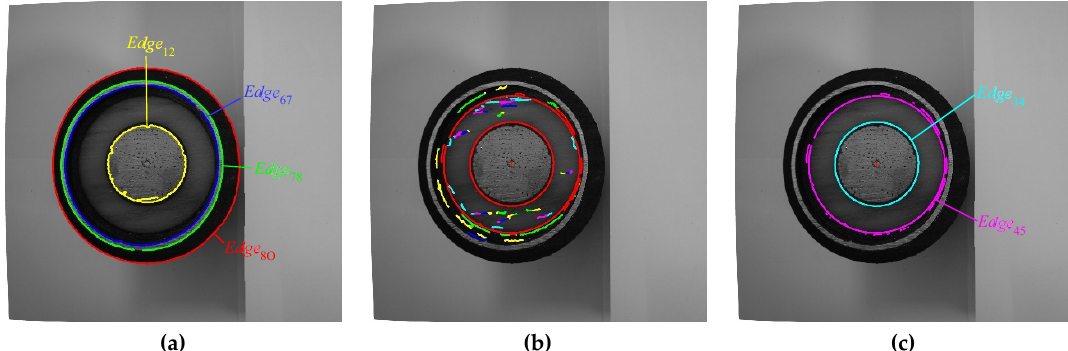
Figure 19. Edge layering. (a) Extraction based on previous coarse contours, in which edges in different layers are rendered with different colors; (b) Annulus division of the left structural edges, in which different annuli are rendered with different colors; (c) Annuli with structural edges.